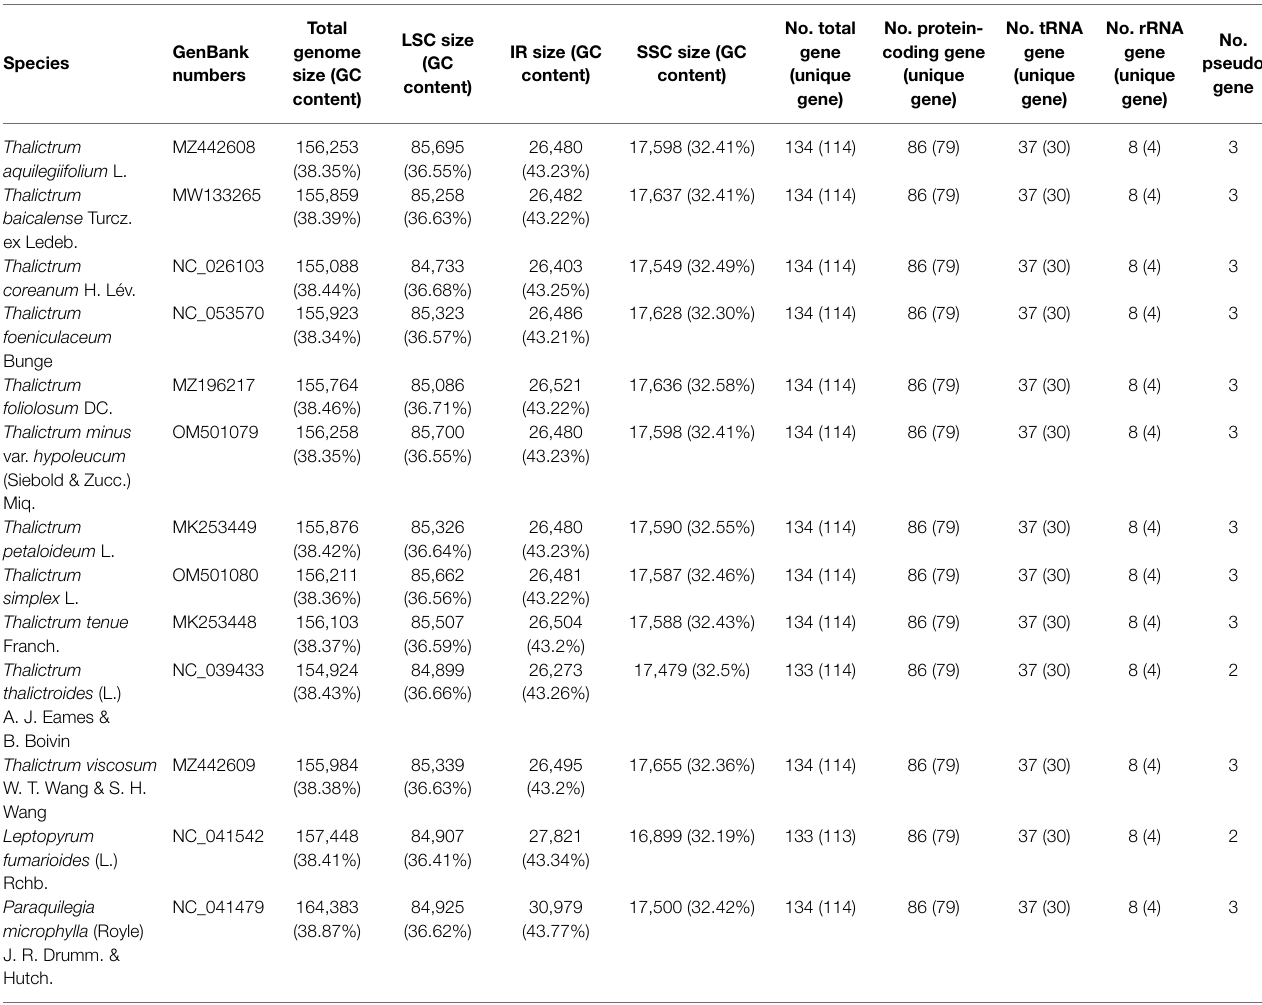
TABLE 1 | Summary of characteristics of plastome sequnences used in the